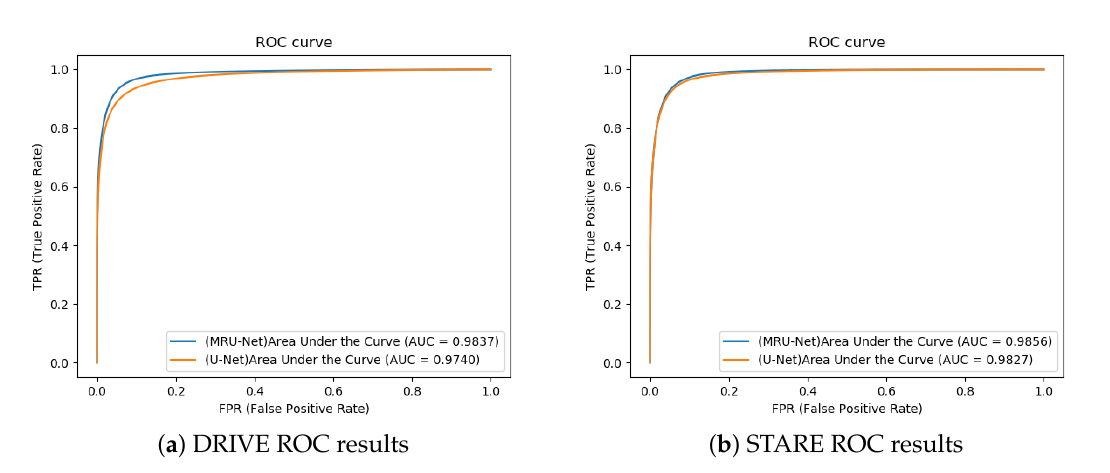
Figure 12. ROC curve: ( a ) DRIVE ROC results and ( b ) STARE ROC